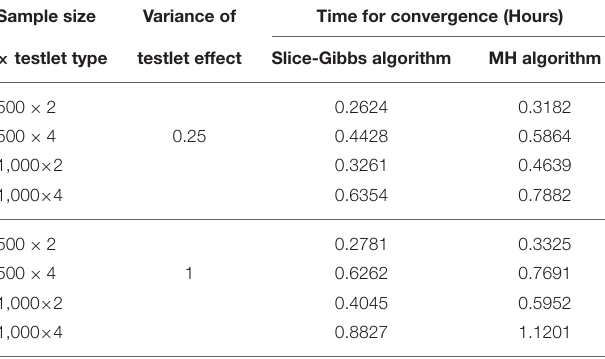
R for the simulation study 1. FIGURE 2 | The trace plots of b TABLE 1 | Convergence times for all 8 simulation conditions in simulation study